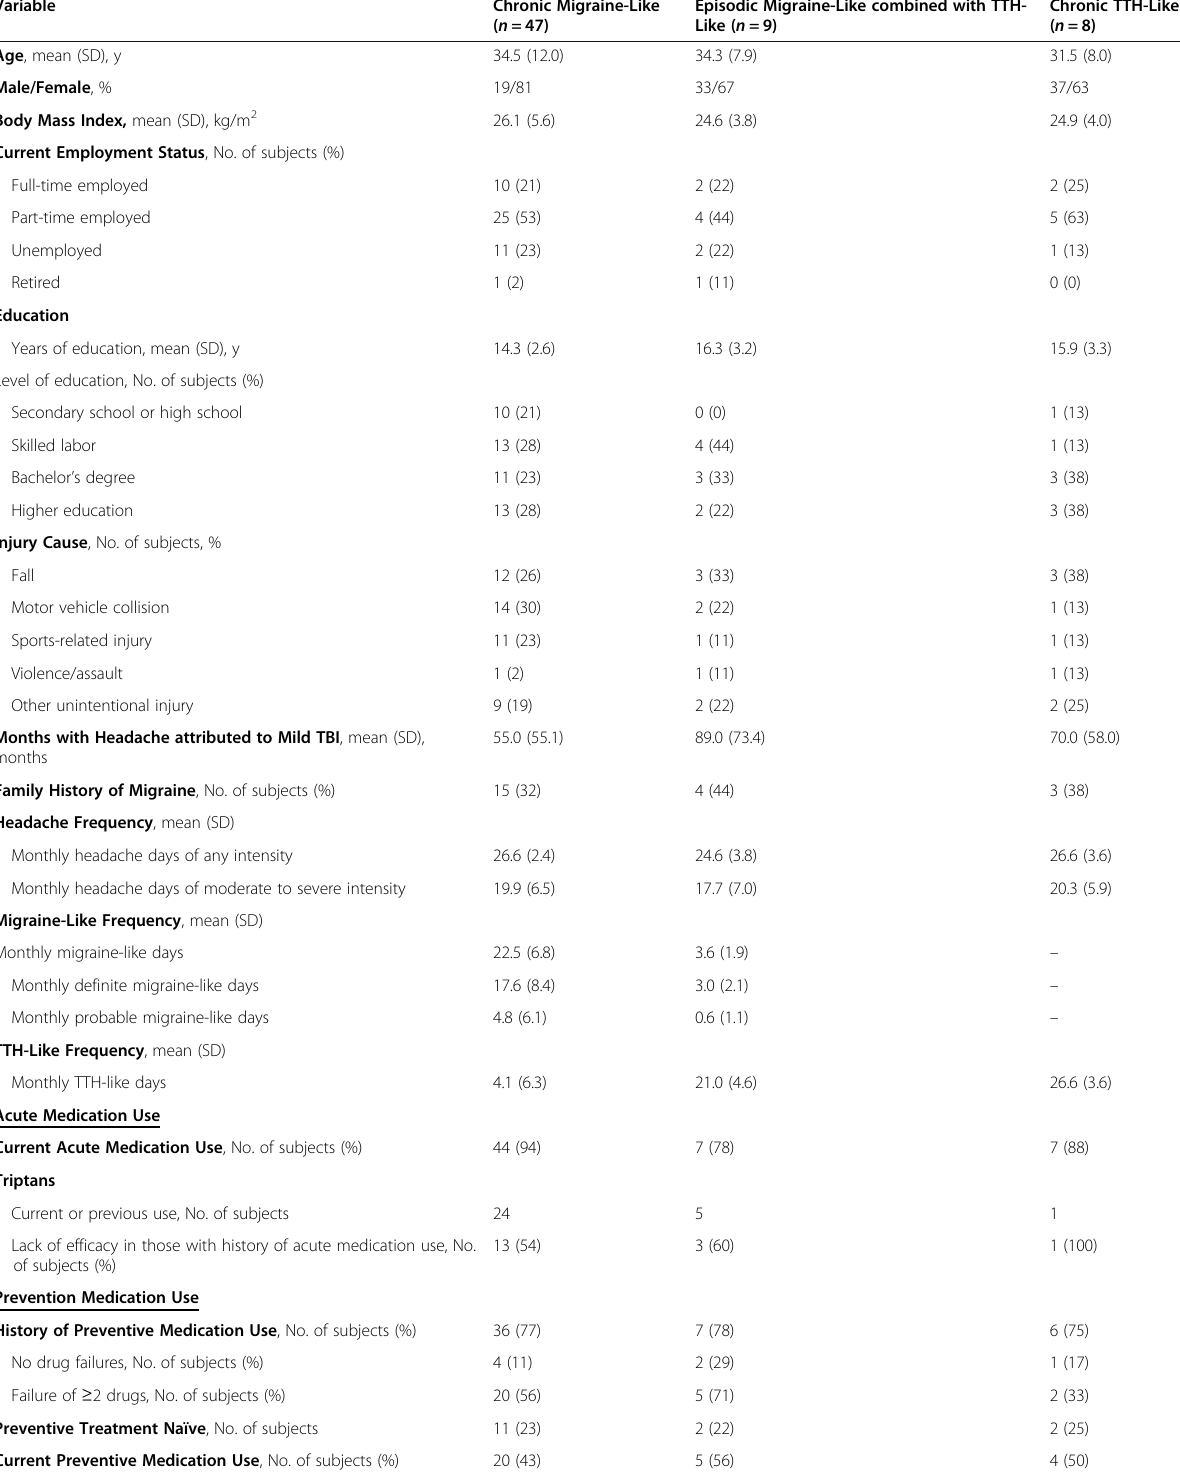
Table 2 Characteristics of Study Population based on Headache Phenotype Diagnosis following Diary